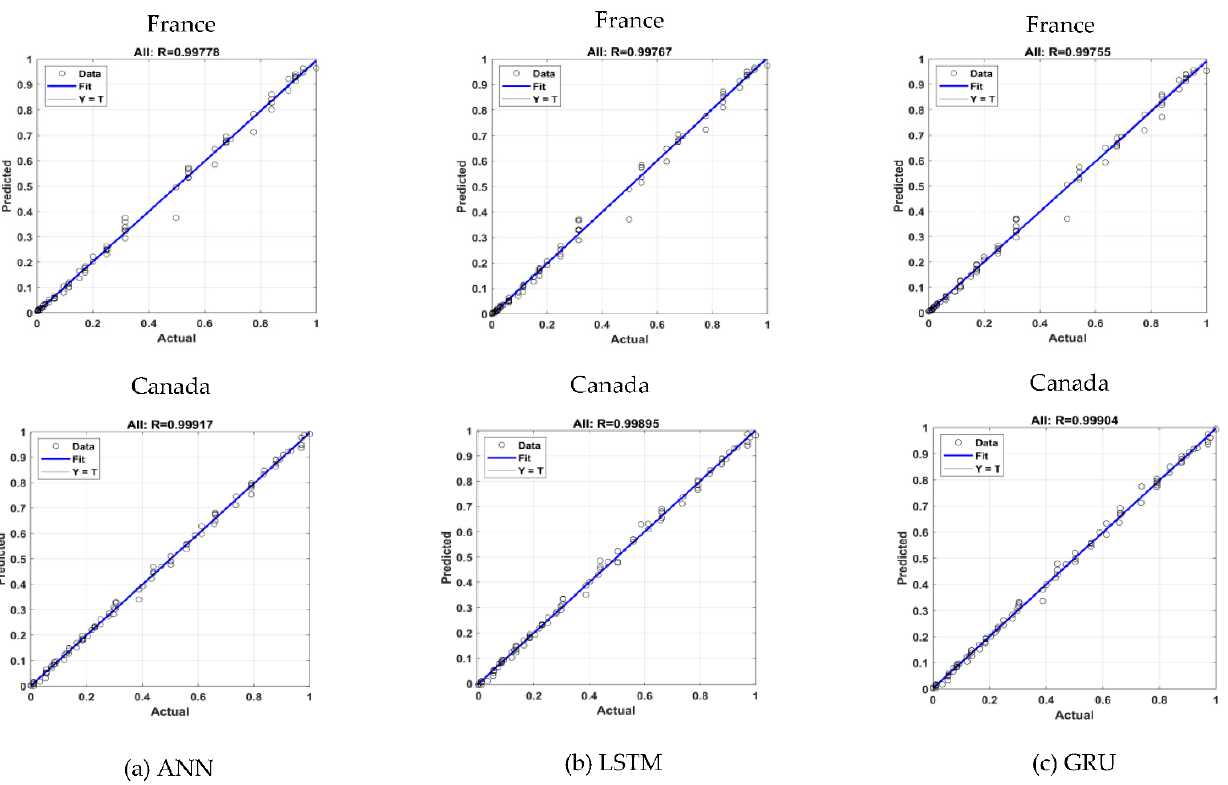
Figure 8. The proposed regression analysis (actual vs. predicted) of neural networks optimal models in predicting—monkeypox.